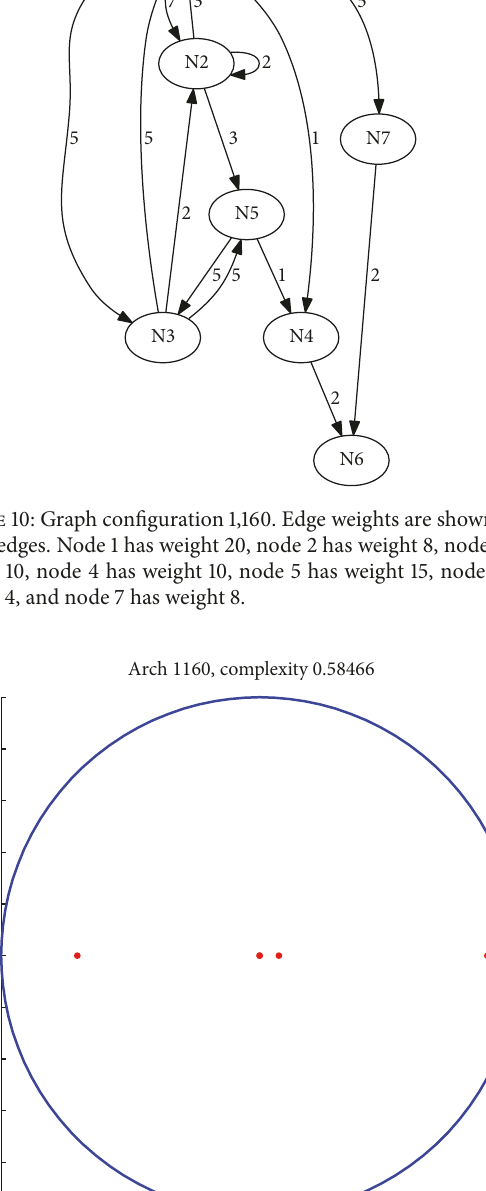
(3) Engine 󳨀→ EPS 󳨀→ Engine (4) APU 󳨀→ EPS 󳨀→ APU (5) Fuel System 󳨀→ APU 󳨀→ EPS 󳨀→ Fuel